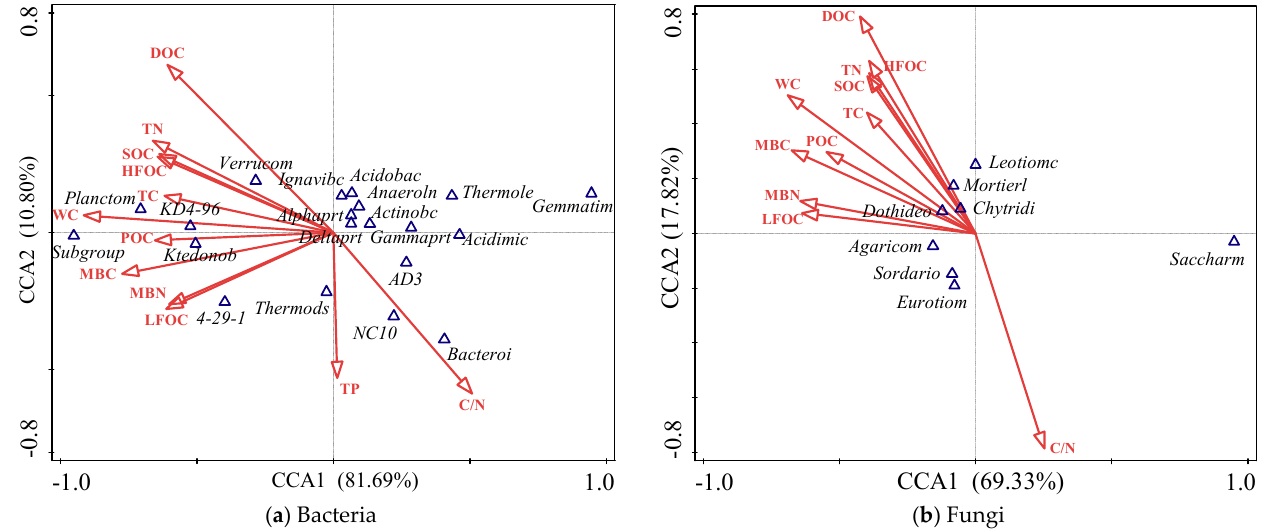
Figure 4. Canonical correspondence analysis (CCA) of soil microbial communities and environmental indices. Acidimic: Acidimicrobiia, Acidobac : Acidobacteriia, Actinobc : Actinobacteria, Alphaprt : Alphaproteobacteria, Anaeroln : Anaerolineae, Bacteroi : Bacteroidia, Deltaprt : Deltaproteobacteria, Gammaprt : Gammaproteobacteria, Gemmatim : Gemmatimonadetes, Ig- navibc : Ignavibacteria, Ktedonob : Ktedonobacteria, Planctom : Planctomycetacia, Subgroup : Subgroup_18, Thermods : Ther-